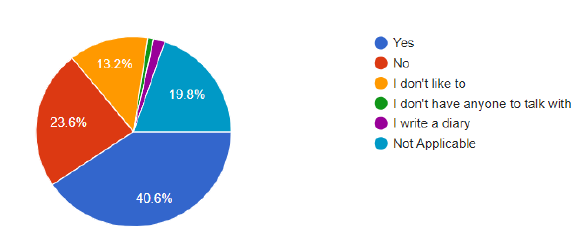
Fig. 8. Percentage of people who talk or consult someone when they feel mentally unstable Finding 9: How would people rate their mental health on a scale of 0-5?